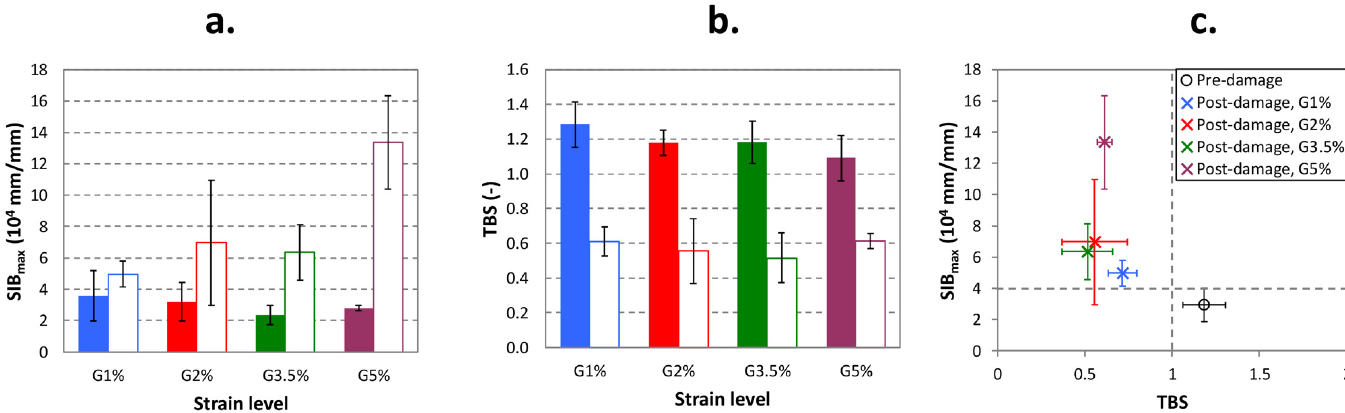
Fig 5. Variation of: a) SIB max and b) TBS—before and after damage—for different mechanical damage levels ( G1% , G2% , G3 . 5% , and G5% ). The filled bars represent the results before damage and the unfilled ones after damage. Panel (b) reproduced with permission from (Mirzaali et al., 2018) PLOS ONE 2018. c) Trend of SIB for pre- and post-damaged specimens considering the mean value and with the standard deviation. Each colour corresponds to a different damage